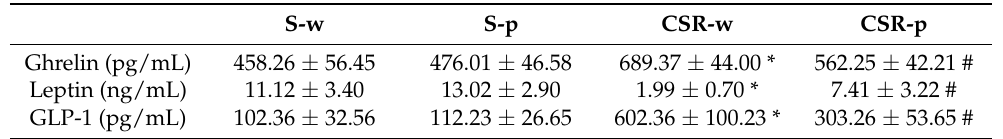
Table 1. Plasmatic levels of ghrelin, leptin, and GLP-1. Values are mean ± SD. One-way ANOVA results were (F (3, 24) = 8.231; p = 0.00061) for Ghrelin, (F (3, 24) = 10.952; p = 0.00010) for Leptin, and (F (3, 24) = 10.269; p = 0.00015) for GLP-1. * indicates statistical significance between S-w and CSR-w, while # indicates statistical significance between CSR-p and CSR-w. S-w S-p